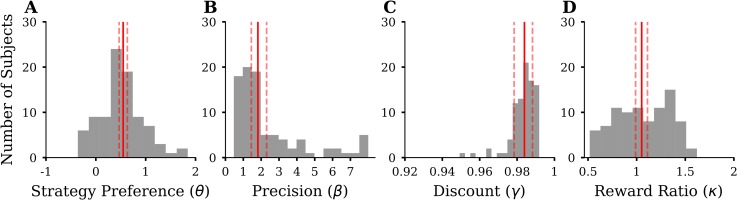
Summary of inferred parameters of the four-parameter model for all 89 participants.We show histograms of the median of the posterior distribution, for each participant. Solid red lines indicate the median of the group hyperparameter posterior estimate with dashed lines indicating 90% credibility intervals (CI). (A) Histogram of strategy preference parameter θ. (B) Histogram of precision parameter β (last bin containing values > 8). (C) Histogram of discount parameter γ. (D) Histogram of reward ratio parameter κ.